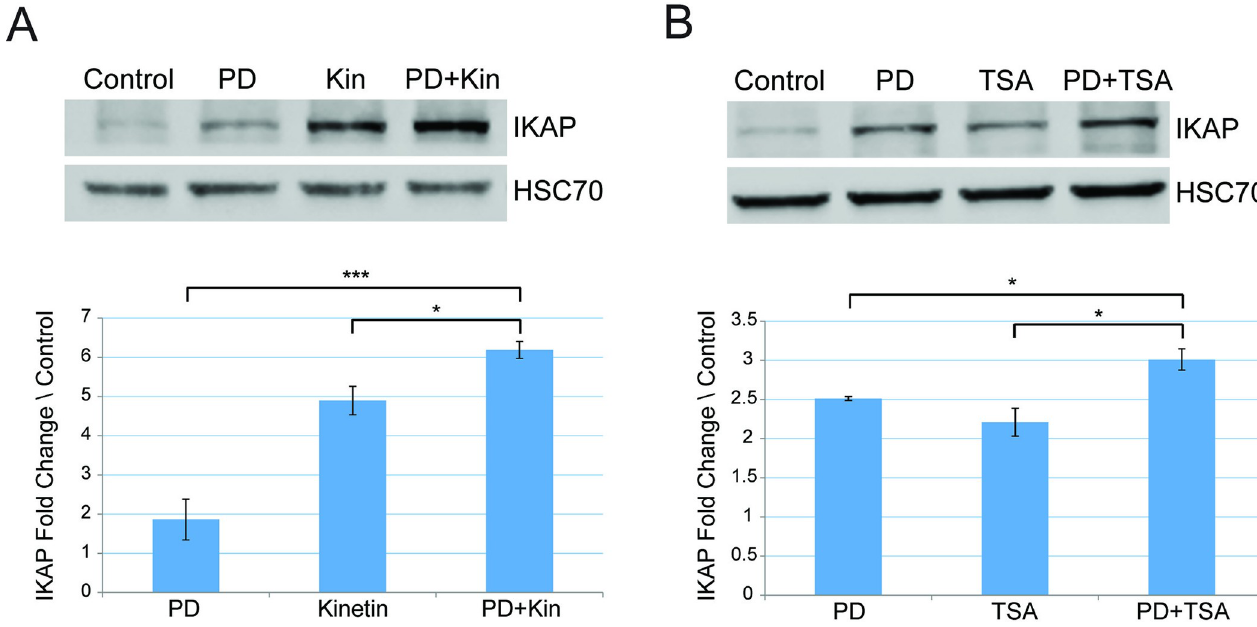
Fig 3. Combined treatments with pridopidine elevates IKAP protein level more efficiently than either drug alone. FD cells were treated for 7 days either with (A) 500 nM pridopidine (PD) or 10 μ M kinetin or and the combination of both drugs, and (B) 500 nM pridopidine or 100 ng/ml TSA or the combination of both drugs. Upper panels: Western blotting of FD cell lysates after indicated treatments. Proteins were extracted, and western blots were analyzed by using anti-IKAP antibody or HSC-70 antibody; the latter was used as a protein-loading control. Lower panels: Quantification of IKAP fold change levels normalized to HSC70 and relative to control (vehicle only). All quantifications were done using FusionCapt software. Asterisks denote statistically significant differences ( � P � 0.05 and ��� P � 0.005) relative to each control; Student’s t -test.